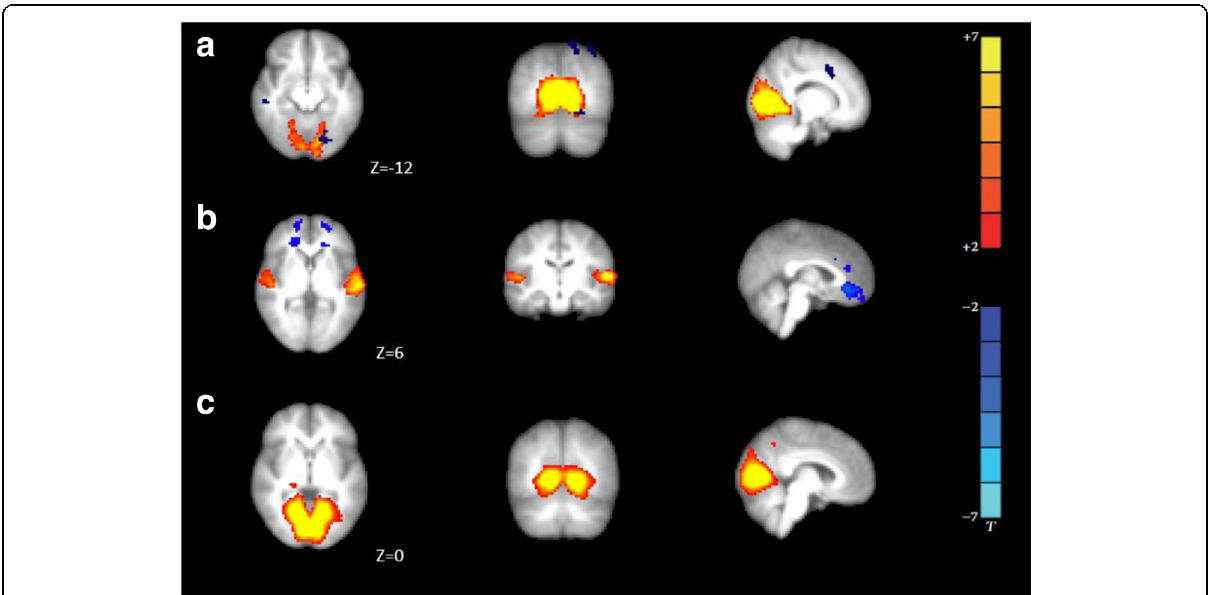
Fig. 1 Functional connectivity average DMN of groups: a. MA > MO group; b. MA > HC; c. MO > HC group . MA patients showed increased functional connectivity compared MO ( blue areas, p values are color coded from 0.05 FWE corrected ( dark blue ) to <0.0001 FWE corrected ( light blue ), full list of structures in Table 2). Axial images are overlaid on transverse slices of MNI-152 standard anatomical image. The left side of the brain corresponds to the right hemisphere and vice versa. Z-coordinates of each slice in the MNI-152 standard space are given (Fig. 1c, full list of structures in Table 5) in both groups. No significant voxels for MO < HC were found.